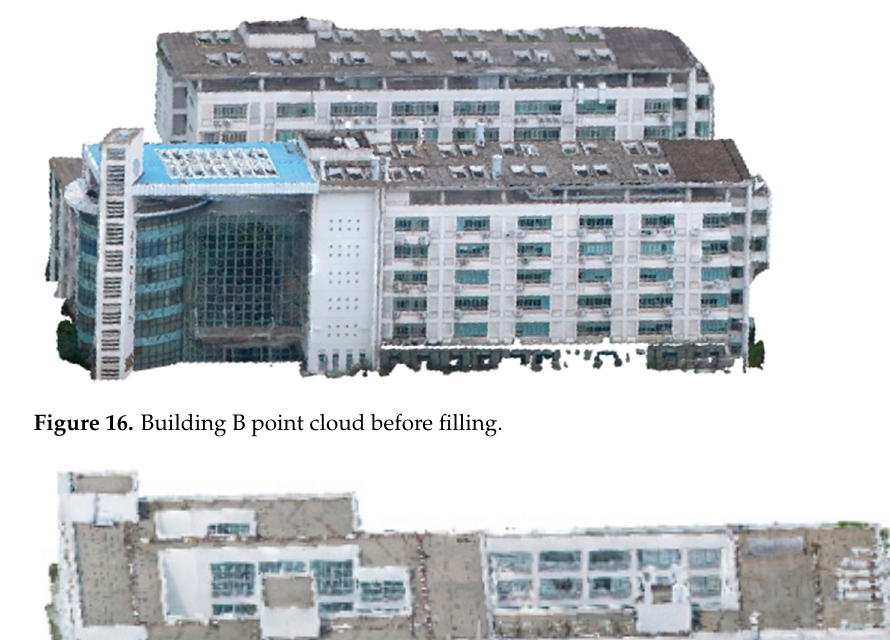
Figure 15. Building A point cloud before filling.